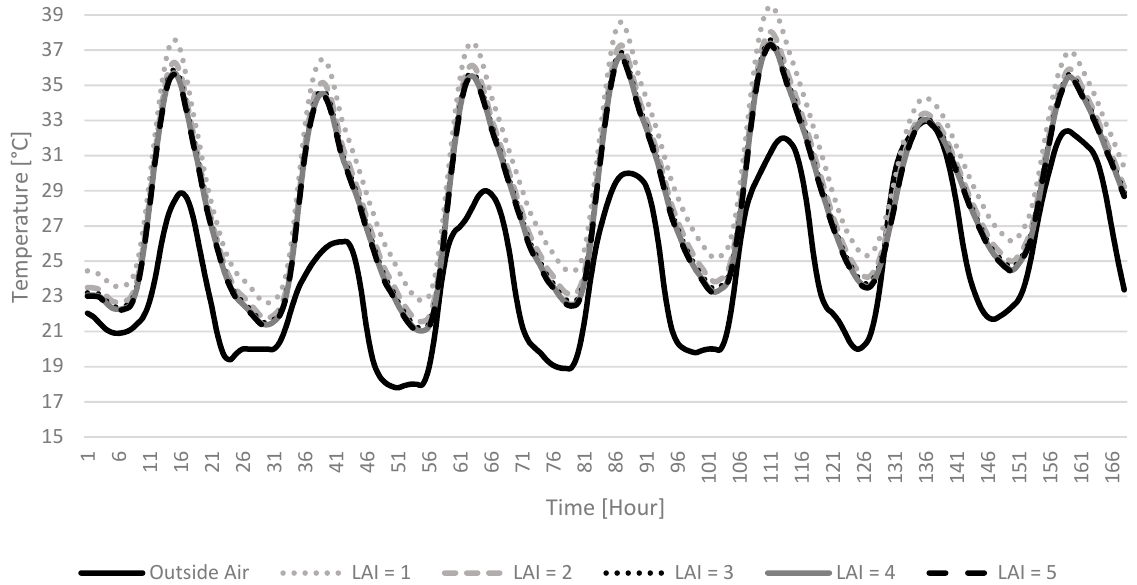
Figure 3. Effect of LAI on the surface external temperature of the walls. Model properties: Substrate in Loam (9 cm); k s = 0.70; air gap thickness = 4 cm.